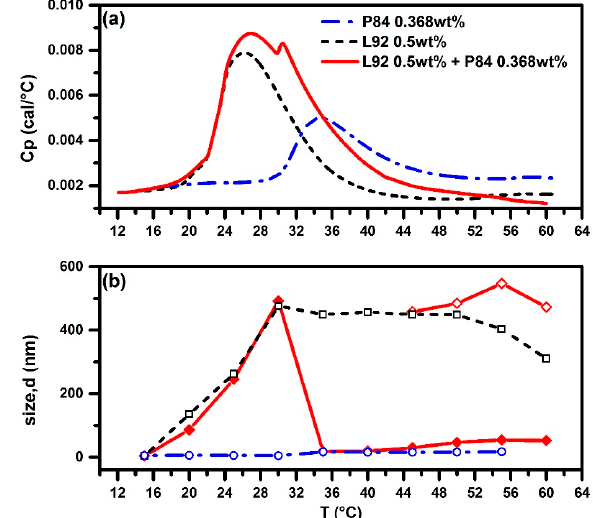
Figure 9. HSDSC thermograms ( a ) and evolution of size of aggregates ( b ) as a function of temperature from DLS for pure 0.5 wt % L92, pure 0.368 wt % P84, and mixed Pluronic 0.5 wt % L92 + 0.368 wt % P84 systems. Red solid line and diamond ( ◆ ) for L92 + P84. Red solid line and open diamond ( ◇ ) for L92 + P84 (the other coexisting aggregates). Black dashed line and open square ( □ ) for pure L92. Blue dashed-dotted line and open circle ( ○ ) for pure P84.